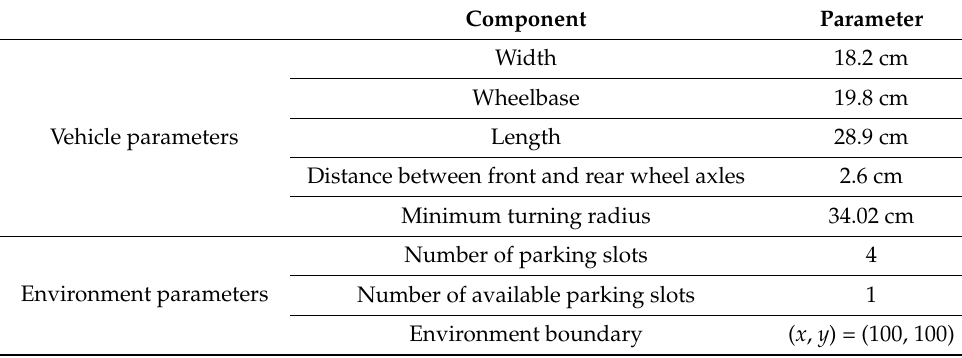
Table 3. Parameters for experimental vehicle and environment.